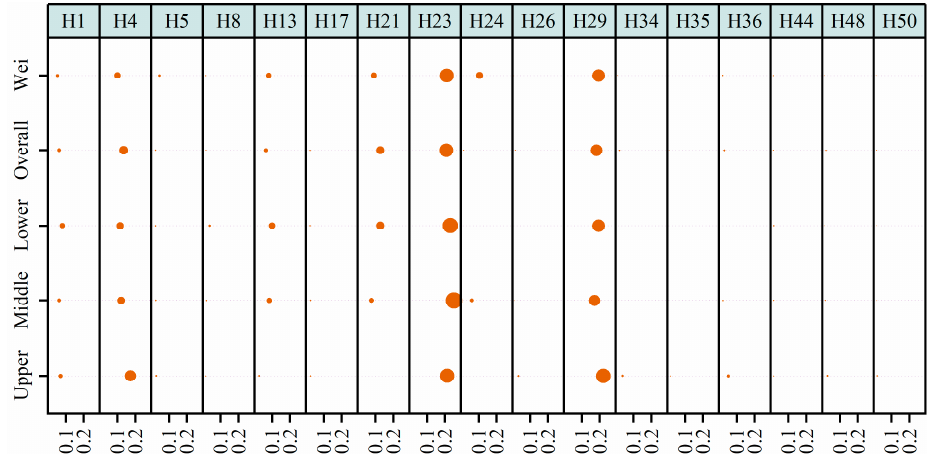
Figure 9. The degrees of limitation to the Happy River Index posed by the assessment indicators of each reach in the Yellow and Wei rivers. Here, the labels “Upper”, “Middle”, “Lower”, and “Overall” refer to the upper, middle, lower, and overall reaches of the Yellow River, respectively, whereas “Wei” refers to the Wei River.